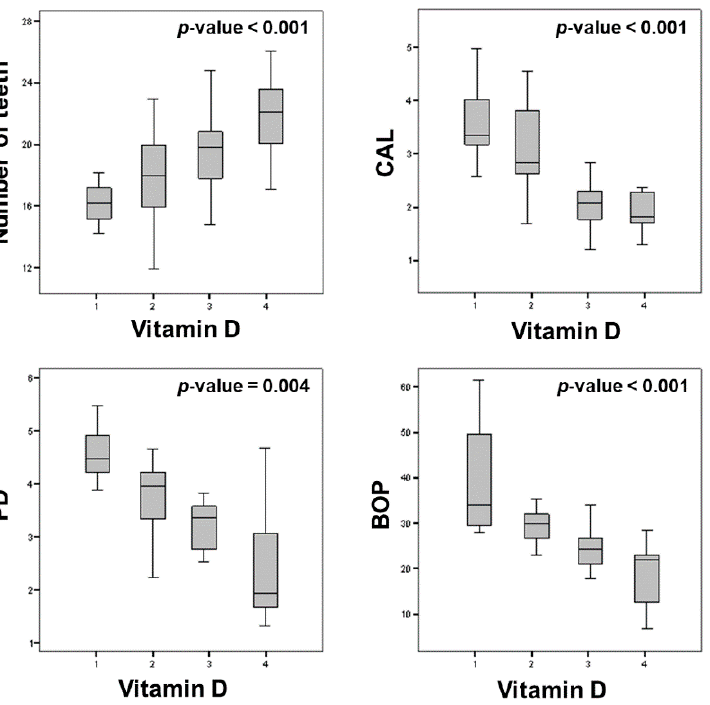
Figure 3. p -trend analysis of increase or decrease vitamin D levels for each single periodontal in- dex.